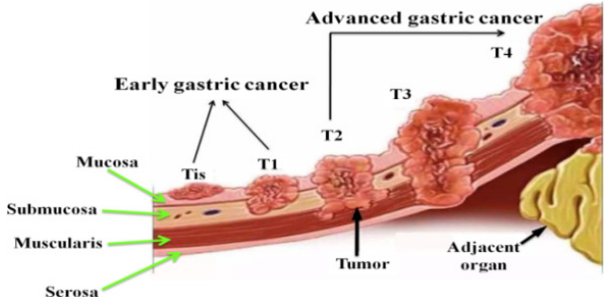
Fig. 1. Clinical stages of gastric cancer. 4 Tis: Carcinoma in situ . Tumor is located in the epithelial layer and does not invade the lamina propria. T1: Tumor invades mucosa or submucosa. T2: Tumor invasion of the muscularis. T3: Tumor penetrates the subserosal connective tissue and does not invade the visceral peritoneum or adjacent tissue. T4: Tumor invasion of the visceral peritoneum or adjacent